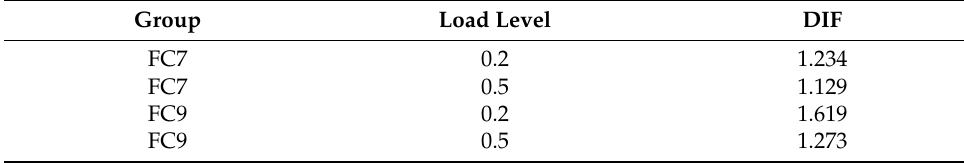
Table 4. DIF of deformation.